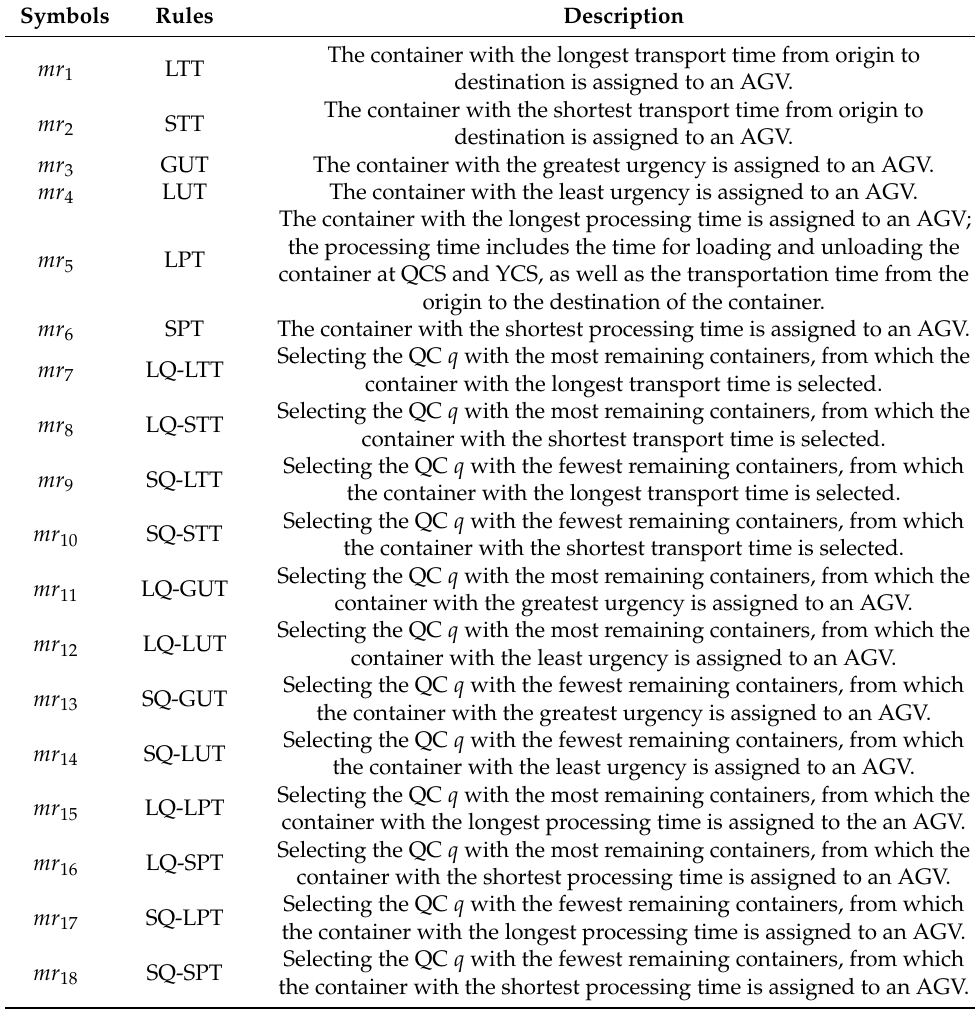
Table 3. Specific details of the heuristic assignment